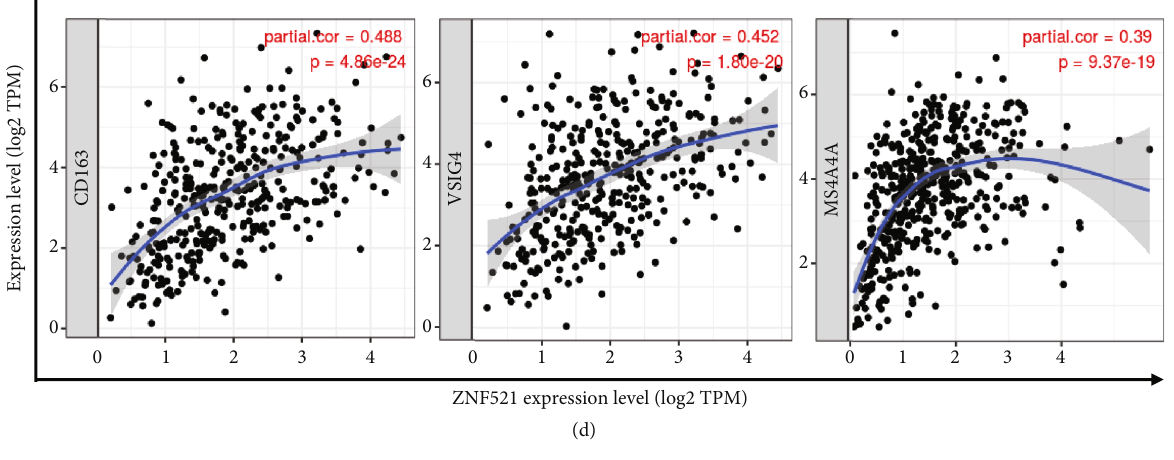
Figure 4: The correlation analysis between ZNF521 expression and immunological marker gene in STAD. Scatterplots of correlations between ZNF521 expression and gene markers of monocytes (a), TAMs (b), and M1 (c) and M2 macrophages (d) in